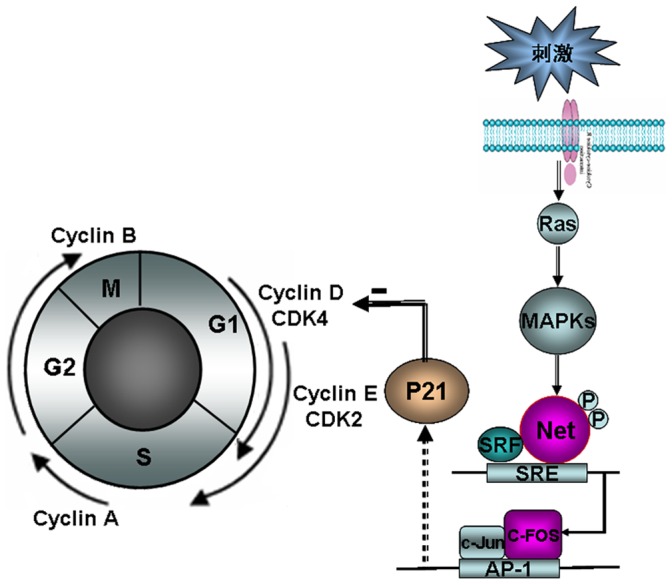
The possible regulatory model of effect of Net on pancreatic ductal adenocarcinoma.Net inhibits the growth of pancreatic ductal adenocarcinoma cell by inhibiting the expression of c-fos, subsequently inactivating the transcription activity of AP-1, followed by activation of p21 to antagonize the effects of Cyclin D/CDK4 on cell cycle progression, and ultimately leading to cell death. On the contrary, phosphorylation of Net is activated by intra or extracellular stimulation signals through Ras-MAPKs pathway, which results in downregulation of Net expression and lack of inhibitory ability on c-fos transcription, thus promoting cell proliferation.